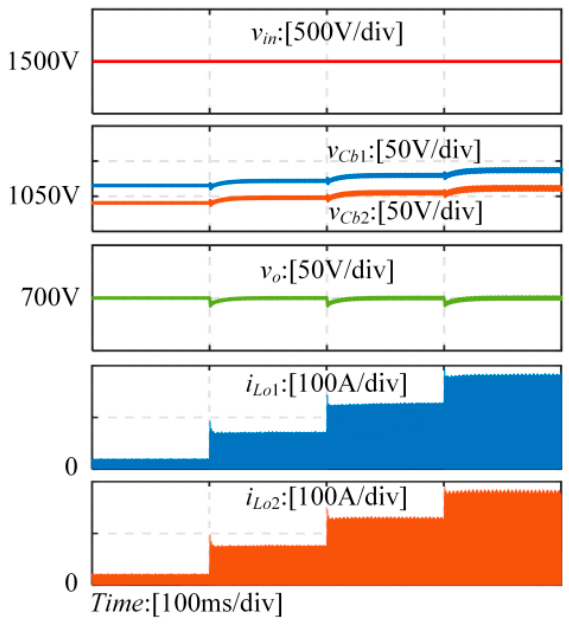
Figure 12. Simulation waveforms when the load changes. The above simulation results show that the inconsistent parameters of the submodules have little influence on the voltage-equalizing effect of the intermediate DC bus, and the ISOP system composed of the Boost+ LLC cascaded module has excellent self-equalizing voltage and current